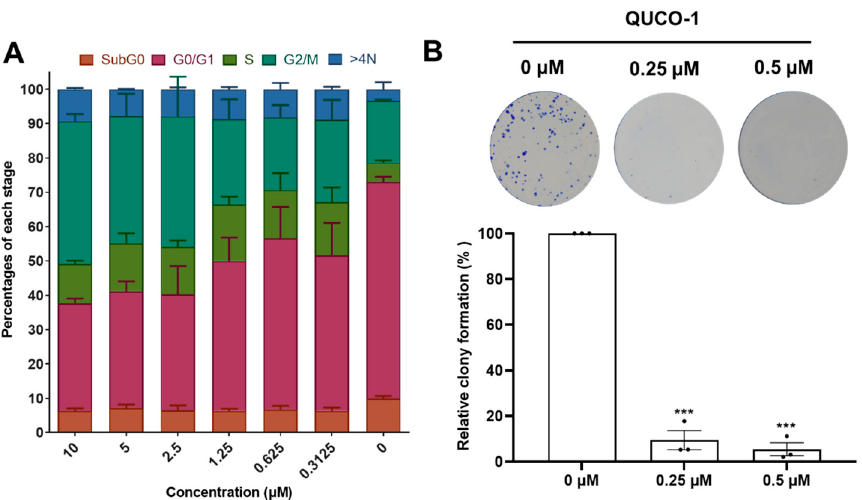
Figure 7. Cell cycle distribution and colony formation after QUCO-1 treatment in RKO cells. ( A ) Cell cycle distribution after 48 h treatment of QUCO-1 . Data are represented as mean ± SEM; n = 200. ( B ) Colony formation after 7 days of treatment of QUCO-1 . All the data were derived from three experiments and expressed as individual points and the mean ± SEM. ns: not significant; * p < 0.05; ** p < 0.01; *** p < 0.001, significantly different from the control.